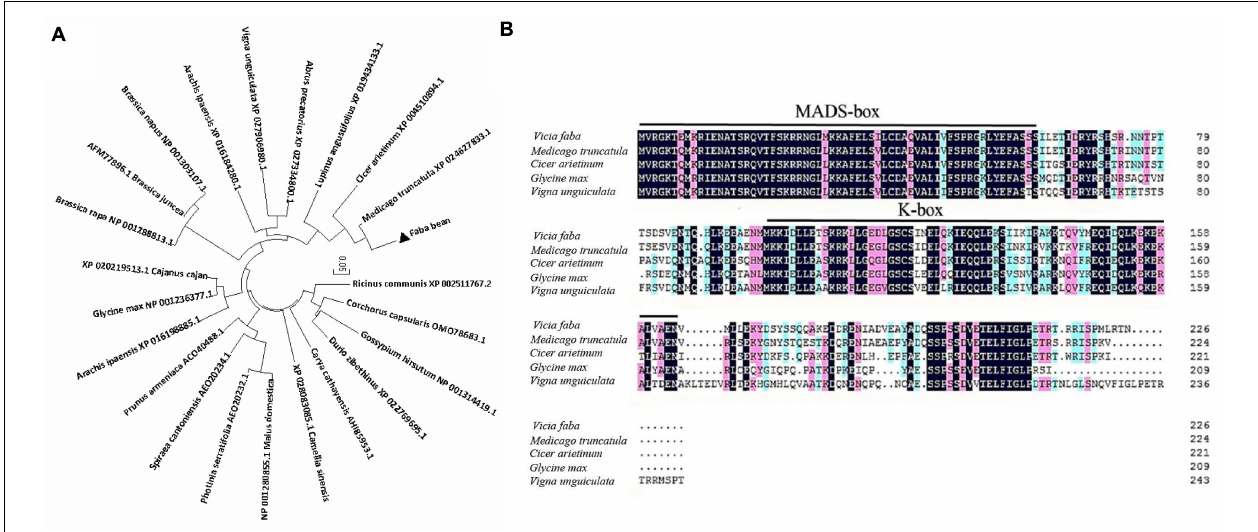
FIGURE 5 | Phylogenetic analysis of VfSOC1 and amino acid sequence alignments with closely related proteins. (A) Neighbor-joining analysis of SOC1 proteins, Numbers indicate the percentage of consensus support. (B) Amino acid alignments of VfSOC1 and ortholog Proteins from Medicago truncatula , Cicer arietimum , Glycine max, and Vigna unguiculata . Conserved residues are shown in black and partial conservation is shown in pink and light blue . The MADS and K-box domains are indicated with black lines ,